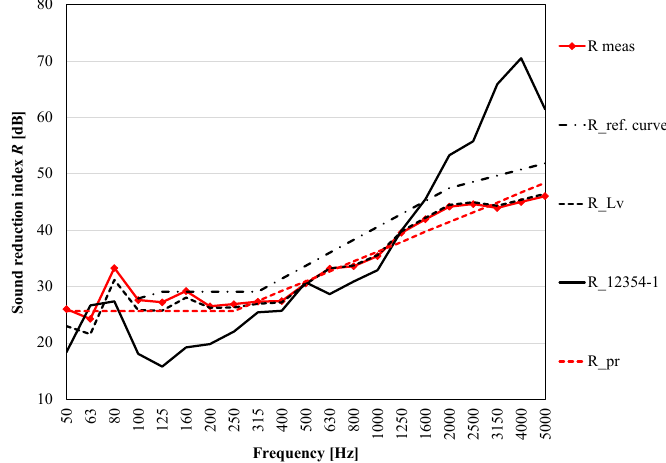
Figure 18. Measured and predicted sound reduction index.